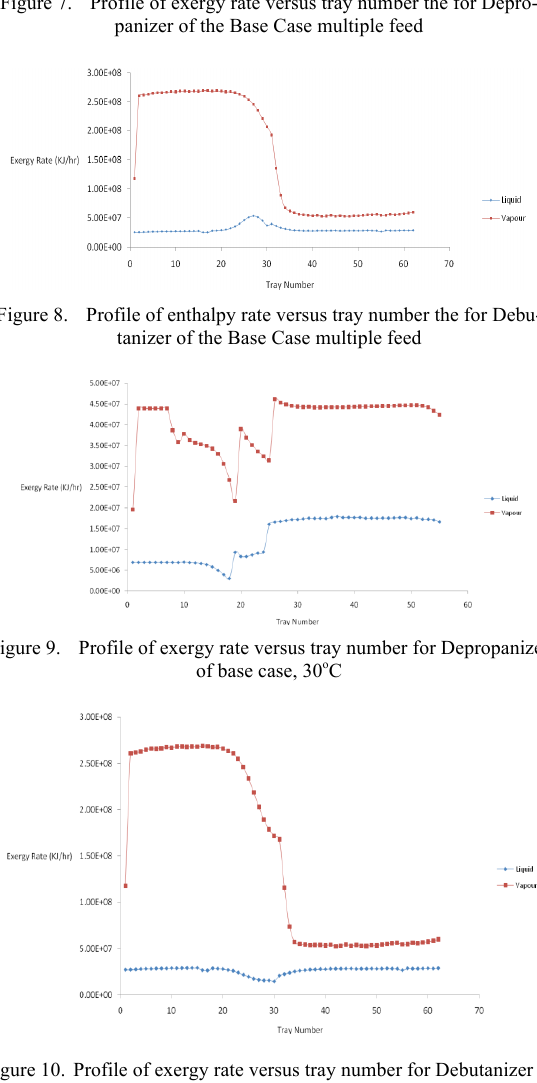
Figure 10. Profile of exergy rate versus tray number for Debutanizer of base case, 30 o